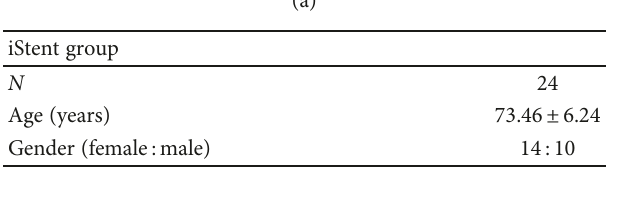
Table 1: Characteristics of the study population in the iStent group and values of fl ow density obtained in the indicated regions before and after surgery. Bold: statistically signi fi cant di ff erences.